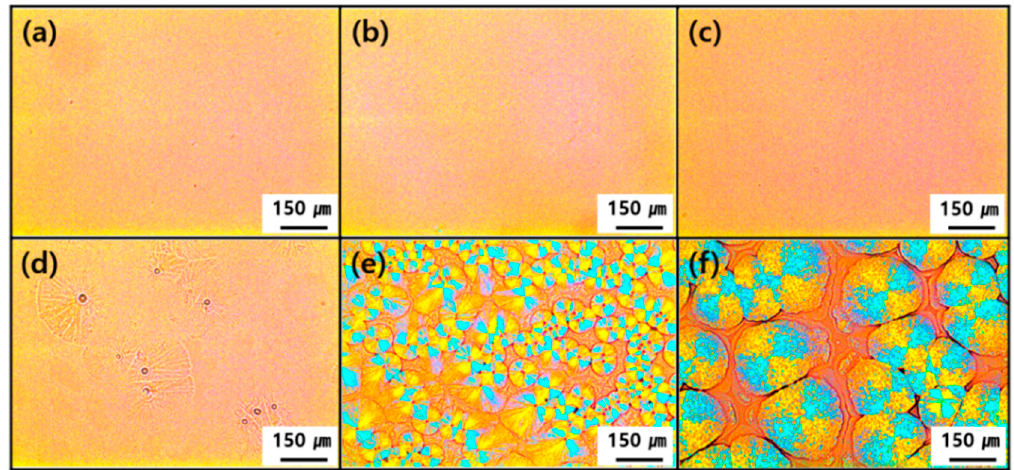
Figure 7. Polarized light microscopy images of ( a ) PIL91, ( b ) PIL73, ( c ) PIL55, ( d ) PIL37, ( e ) PIL19, and ( f ) LPEGMASQ82.